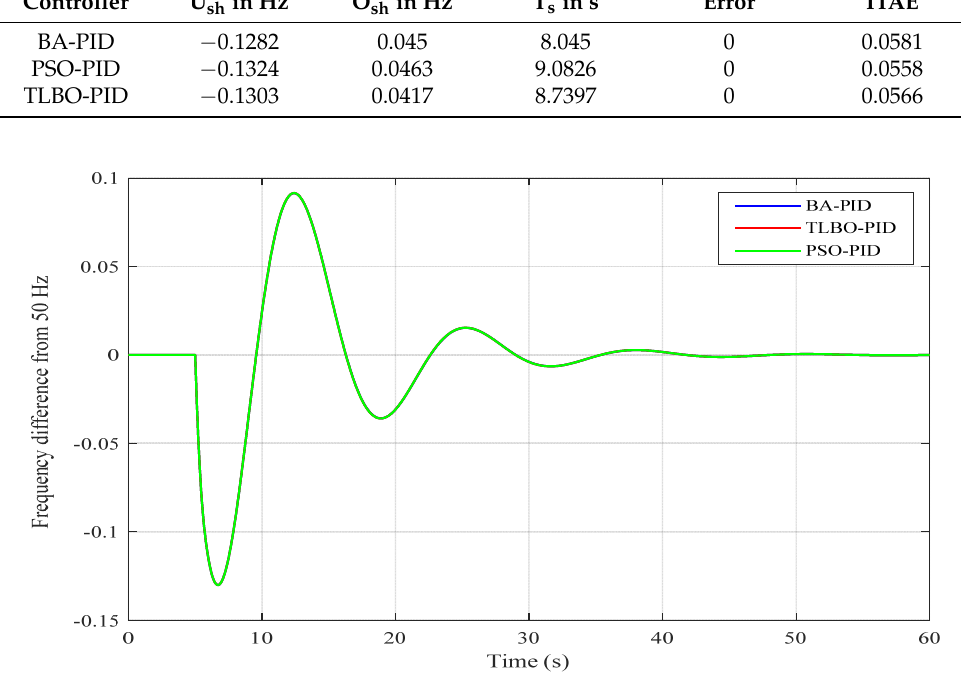
Figure 6. Change in frequency in the GB power system for 0.035 pu load disturbance with tuned PID-based ISE.